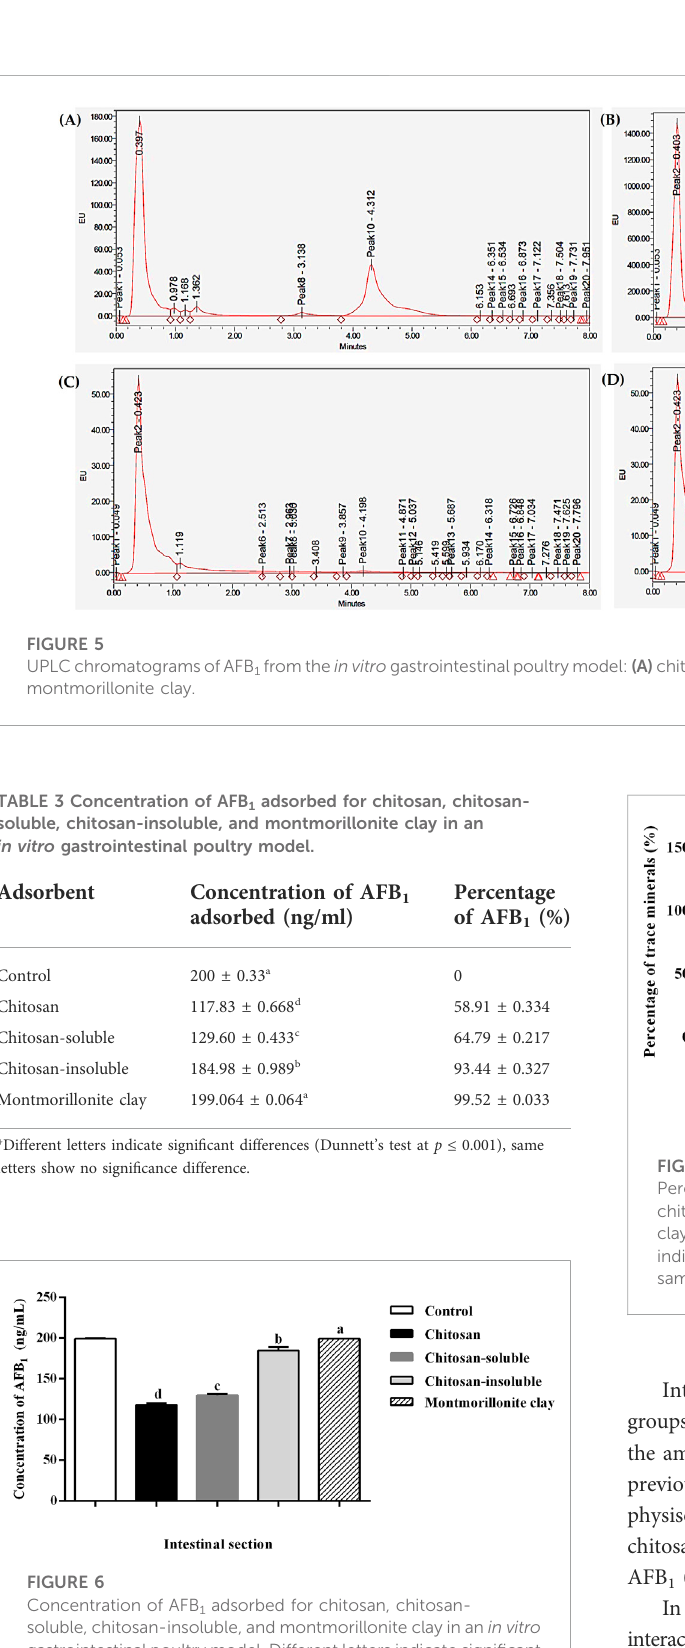
FIGURE 6 Concentration of AFB 1 adsorbed for chitosan, chitosan- soluble, chitosan-insoluble, and montmorillonite clay in an in vitro gastrointestinal poultry model. Different letters indicate signi fi cant differences (Dunnett ’ s test at p ≤ 0.05).